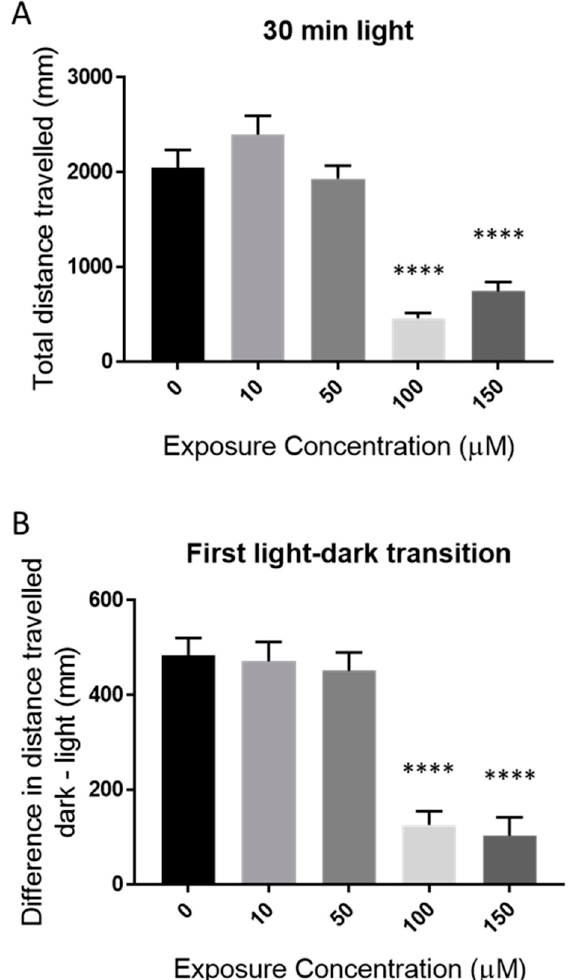
Figure 2. Behavioral effects of catechol on 72 hpf zebrafish larvae. Zebrafish larvae were exposed to a range of catechol concentrations for 48 h. Their activity was measured as total distance traveled over 30 min ( A ) and the first light–dark transition ( B ). Asterisks represent differences between concentrations, **** p < 0.0001.